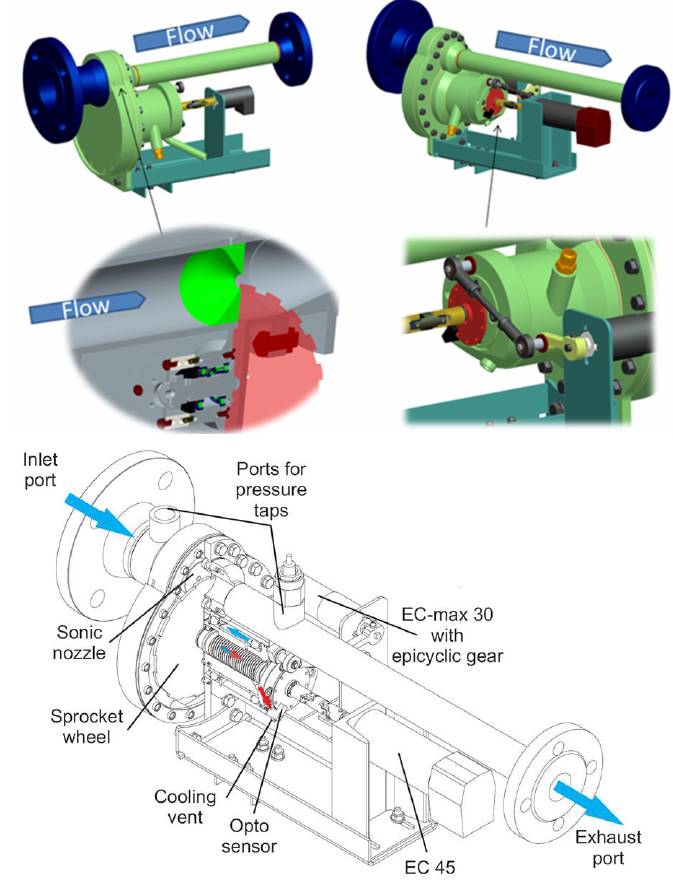
Figure 4. TU Graz siren, with details of the nozzle and wheel assembly, as well as the connecting rod, able to change the free critical surface based by moving the eccentric shaft of the cogged